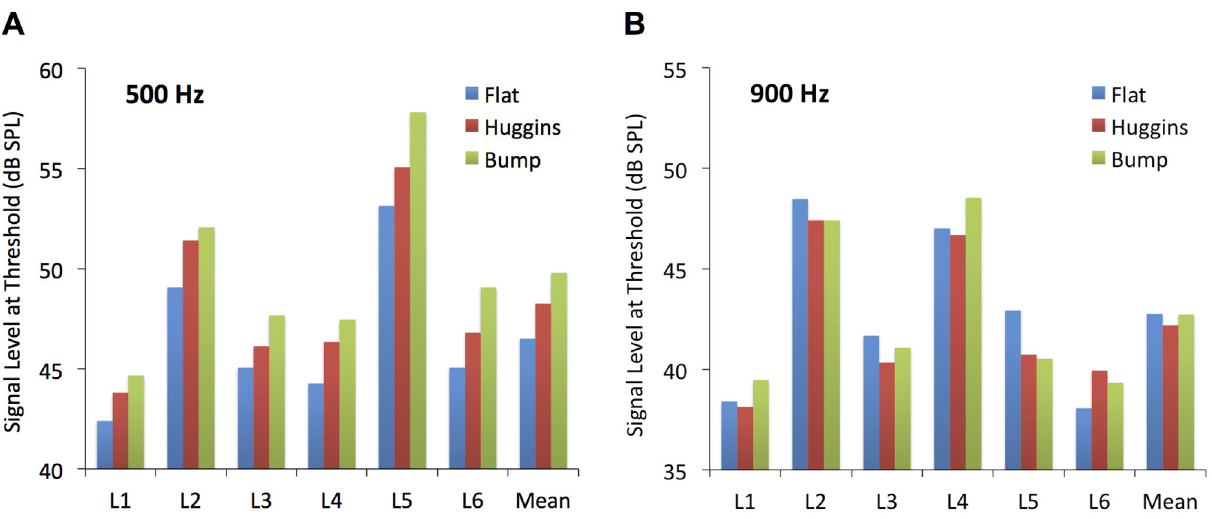
Figure 2. The individual and mean results of the main experiment. The different panels show the results for the 500 Hz ( A ) and 900 Hz ( B ) signal frequencies. Signal levels at threshold for the Flat, Huggins, and Bump conditions are shown by the blue, red, and green bars